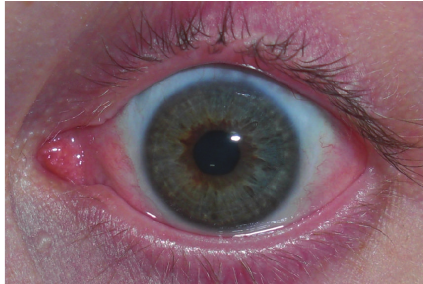
Figure 4: Patient with total limbal stem cell deficiency after chem- ical burn who underwent keratolimbal allograft and penetrating keratoplasty with systemic immunosuppression (18 months after